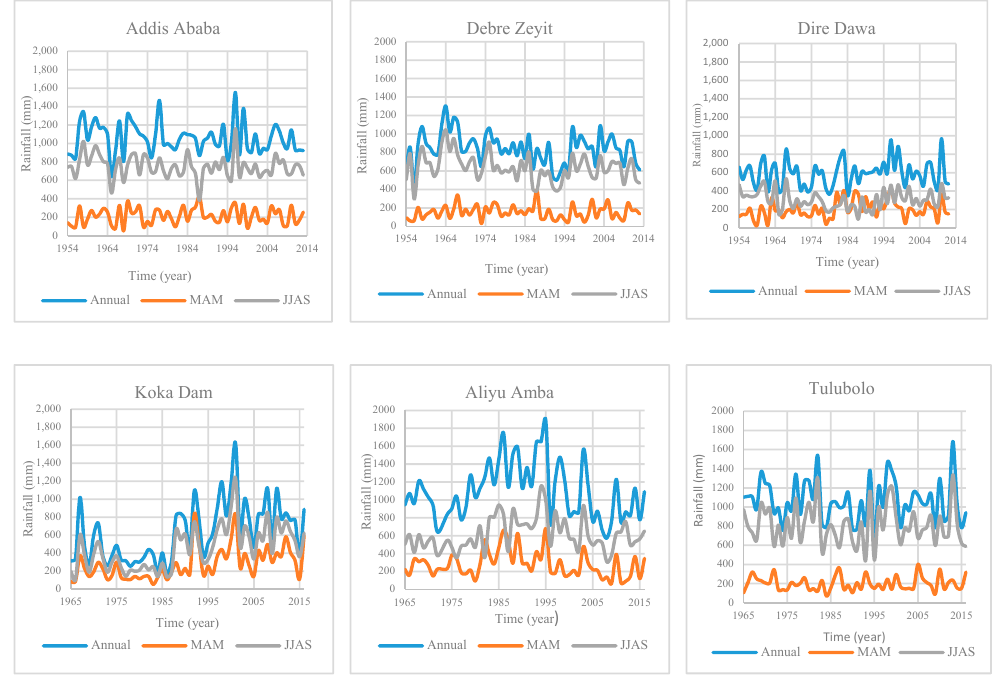
Figure 4. Seasonal temporal variability of rainfall (mm) in selected stations in Groups 1 and 2 (JJAS—June to September; MAM—March to May) .